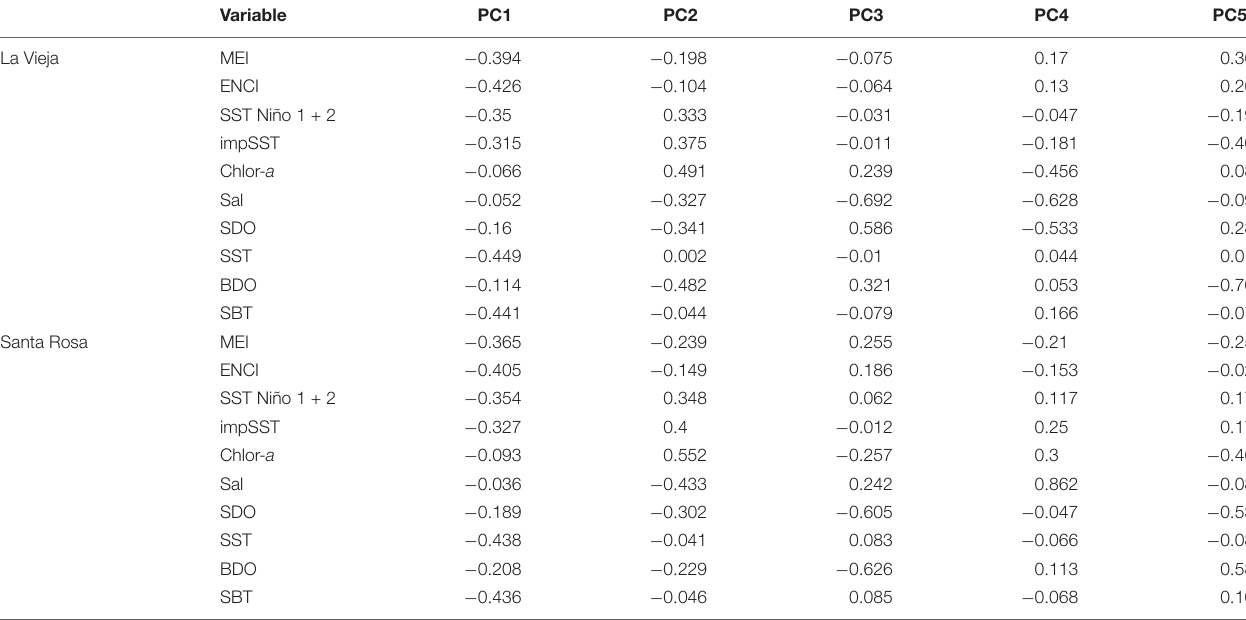
TABLE 2 | Results of the principal components analysis of regional and local environmental variability at La Vieja Island and Santa Rosa Island. Variable PC1 PC2 PC3 PC4 PC5